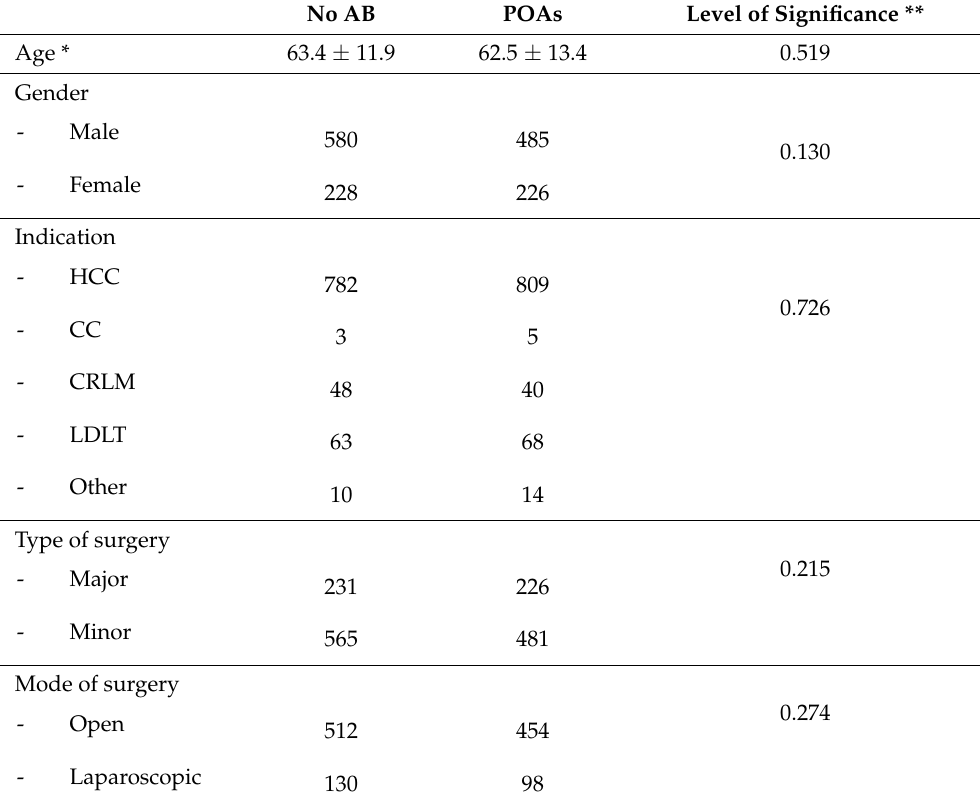
Table 4. Summary